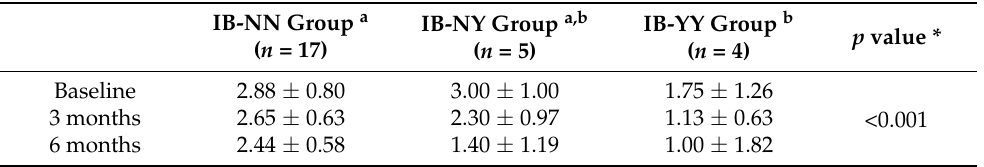
Table 4. Bleeding on full-mouth interdental brushing (BOFIB) index according to full-mouth inter- dental brushing ( N = 26).